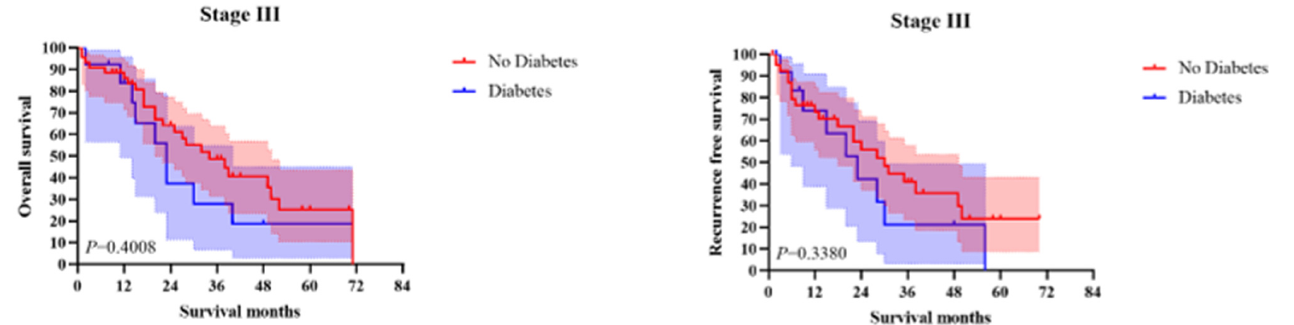
Figure 2. Subgroup survival analysis according to the tumor stage.